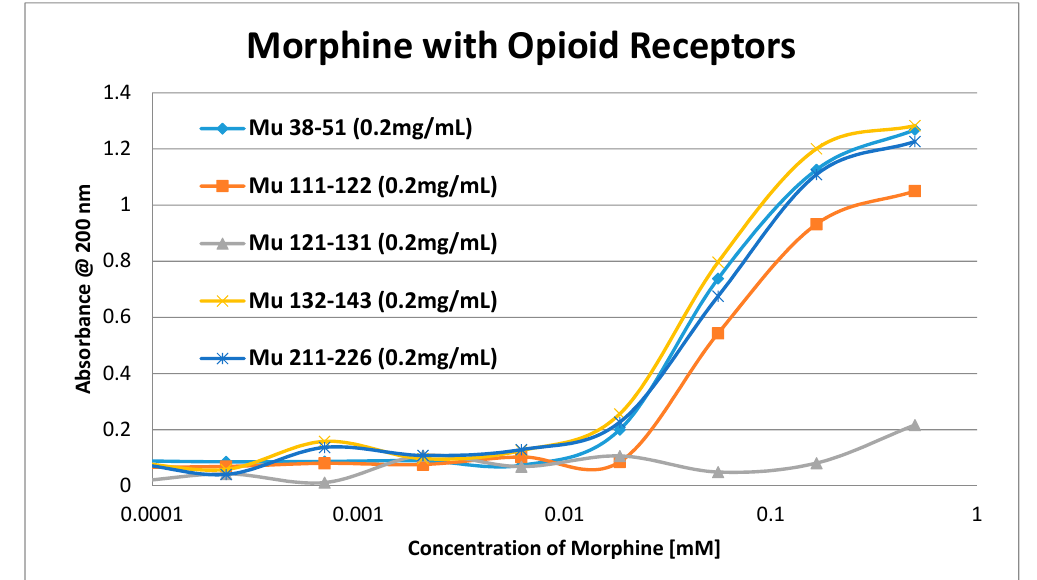
Figure 6. UV spectroscopic study of dopamine binding to mu opioid receptor (muOPR) peptides derived from the extracellular loop and adjacent transmembrane regions (see Figure 1).